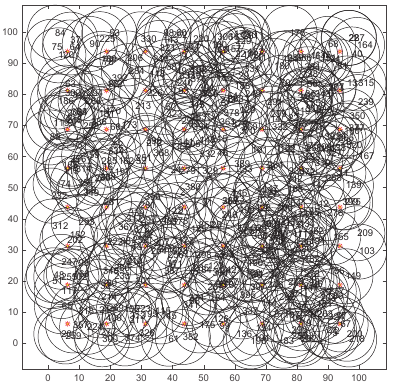
Figure 8. Distribution of 400 random nodes and 64 monitoring target points.